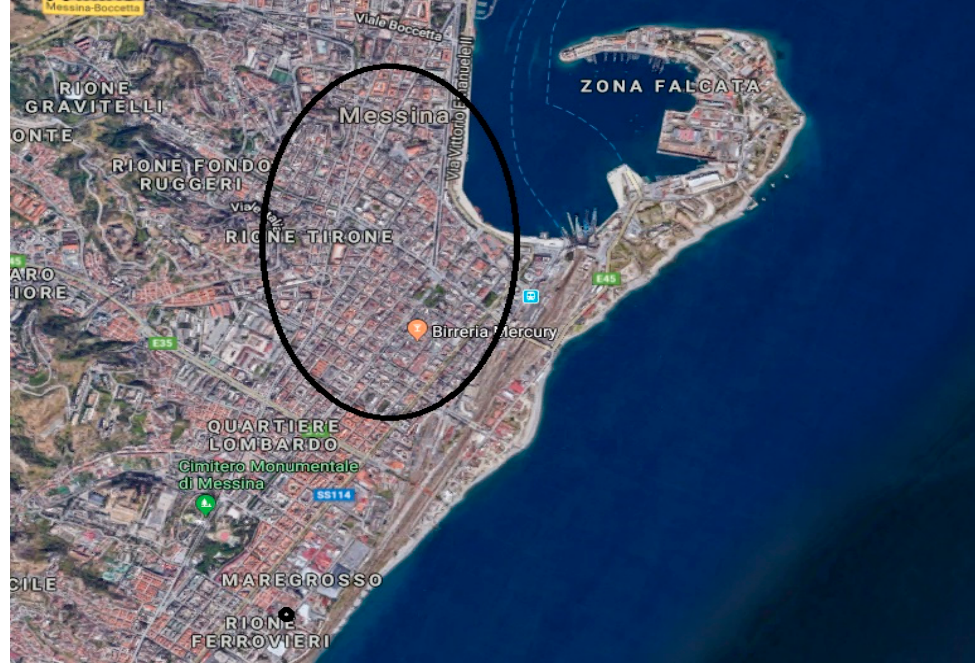
Figure 6. The map shows the area of the city of Messina considered in the TSR ® research (2014–